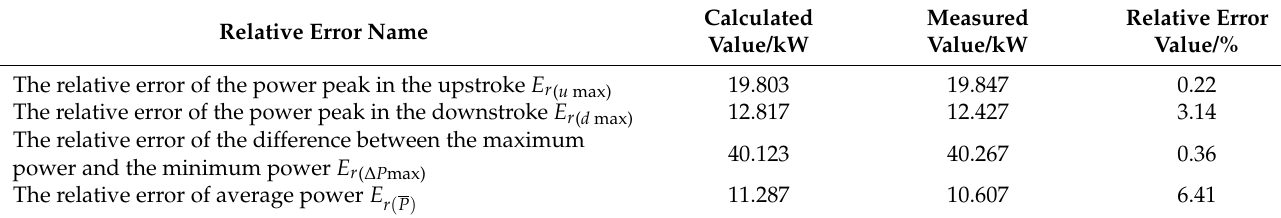
Figure 7. Measured and calculated the electric power diagram of well X1. The error between the calculated and measured electric power diagram is analyzed, and the results are shown in Table 3. According to the error calculation results, the accuracy of the electric power diagram calculated based on the dynamometer card in well X 1 is high, and it has a good fitting with the measured electric power diagram, which indicates that the accuracy of the model for calculating electric power diagram in the variable torque pumping unit well has high accuracy. Table 3. Error analysis